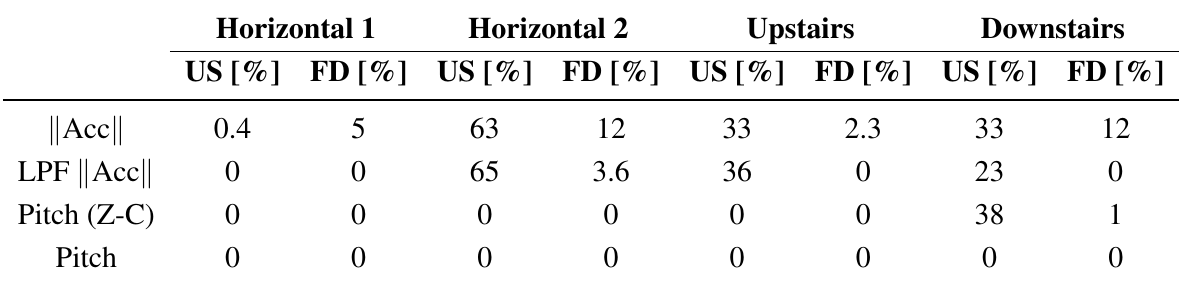
Table 1. Performance comparison of different step detectors.